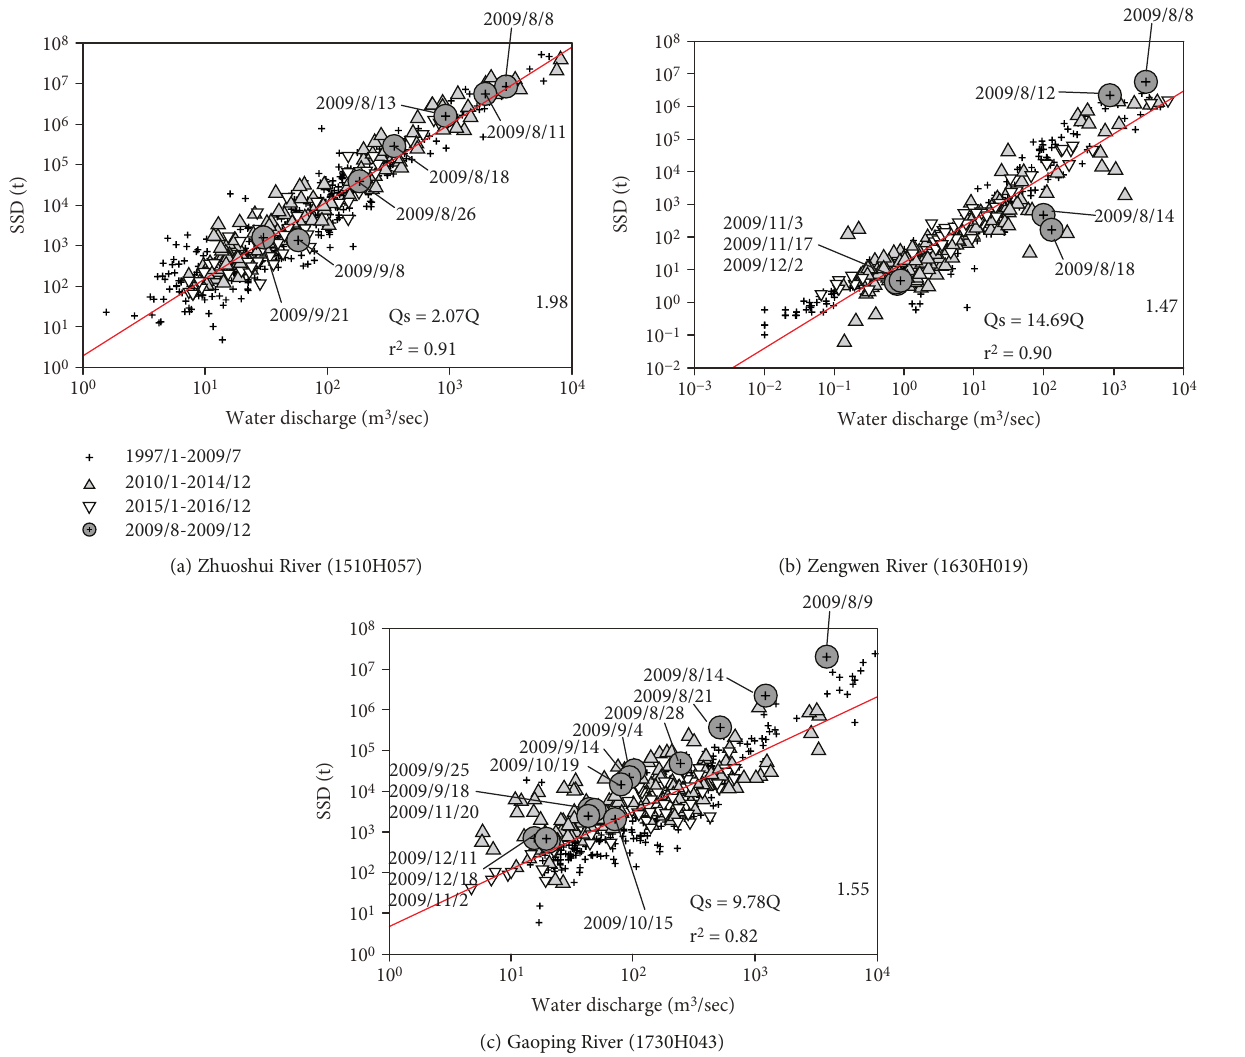
Figure 2: Relationship between suspended sediment discharge ( Q Zengwen River, and (c) the Gaoping River. The red lines represent the regression lines of all 1997 – 2016